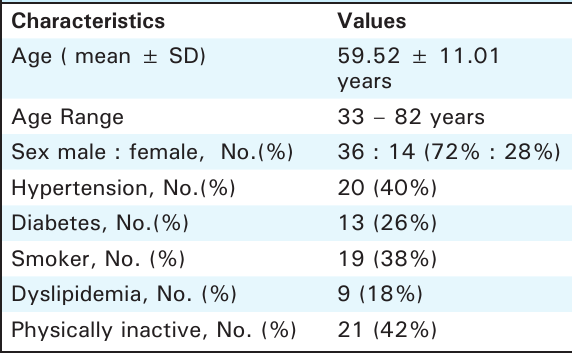
Table 1. Baseline characteristics of enrolled subjects.